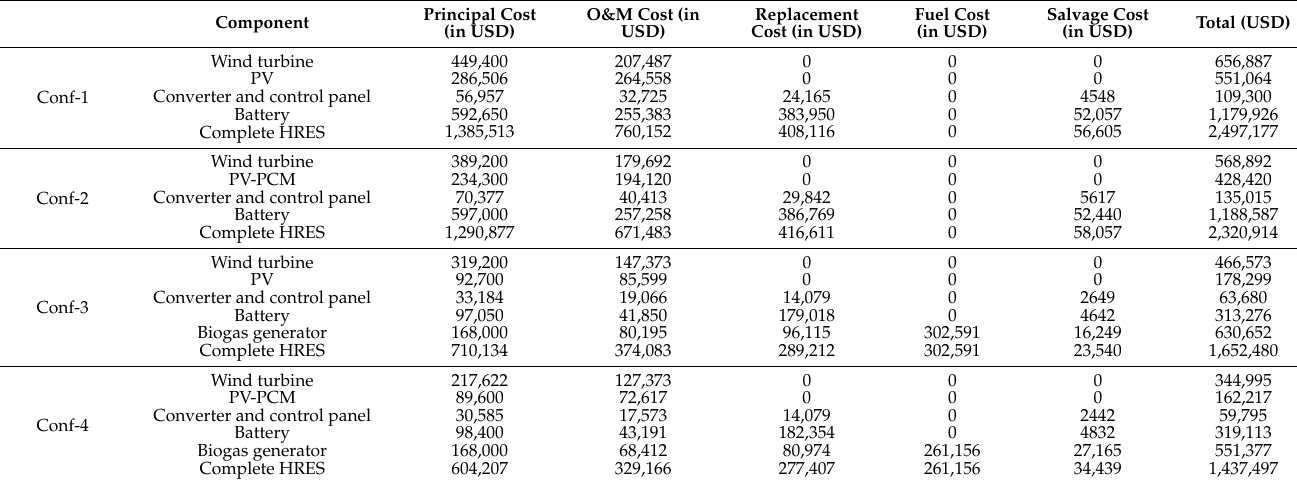
Table 8. Cost breakdown of net present cost of HRES system in different configurations.